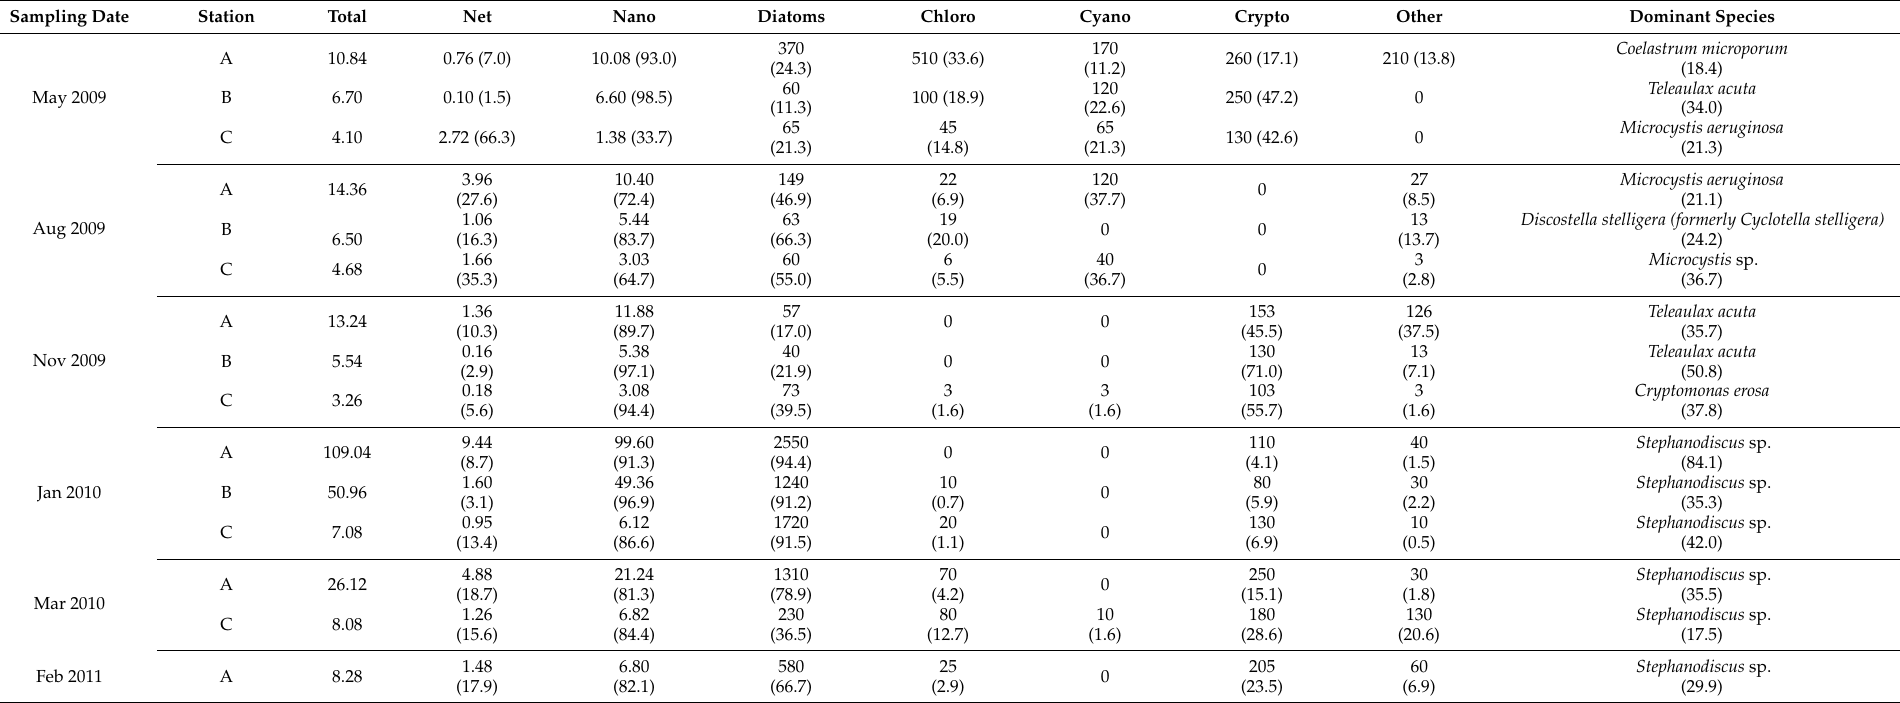
Table 2. Total, net- and nanosized chl a concentrations ( µ g L − 1 ) and cell abundance (cells mL − 1 ) in taxonomic groups and their contribution percentages (% in parenthesis) in the surface water at stations A, B, and C in the freshwater zone of the Yeongsan River estuary: S Date, Sampling date; Chloro, Chlorophytes; Cyano, Cyanobacteria; Crypto, Cryptophytes; Others, Other